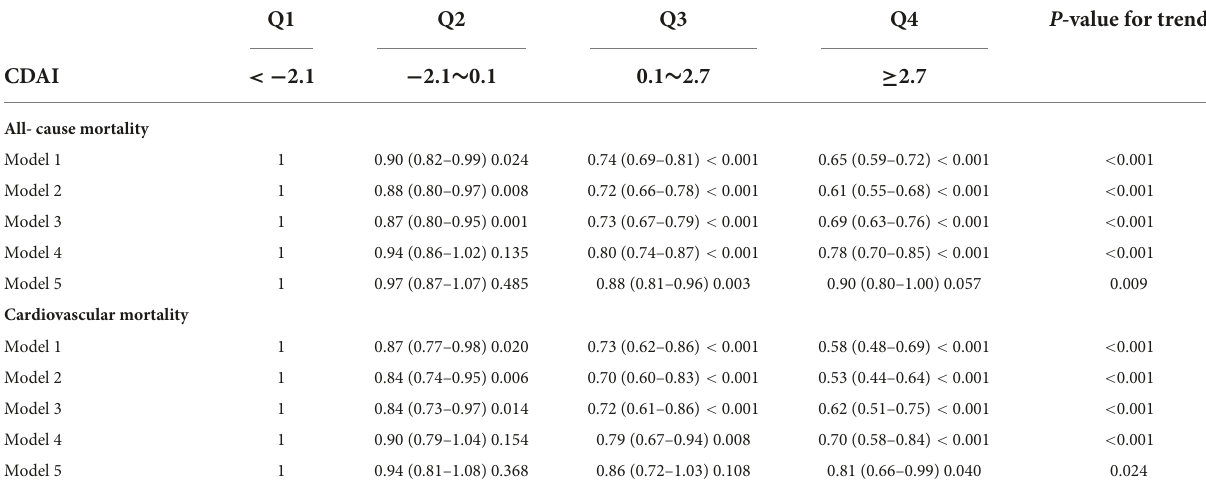
TABLE 2 Weighted associations between the CDAI and all-cause and cardiovascular mortality in the multivariable, and crude